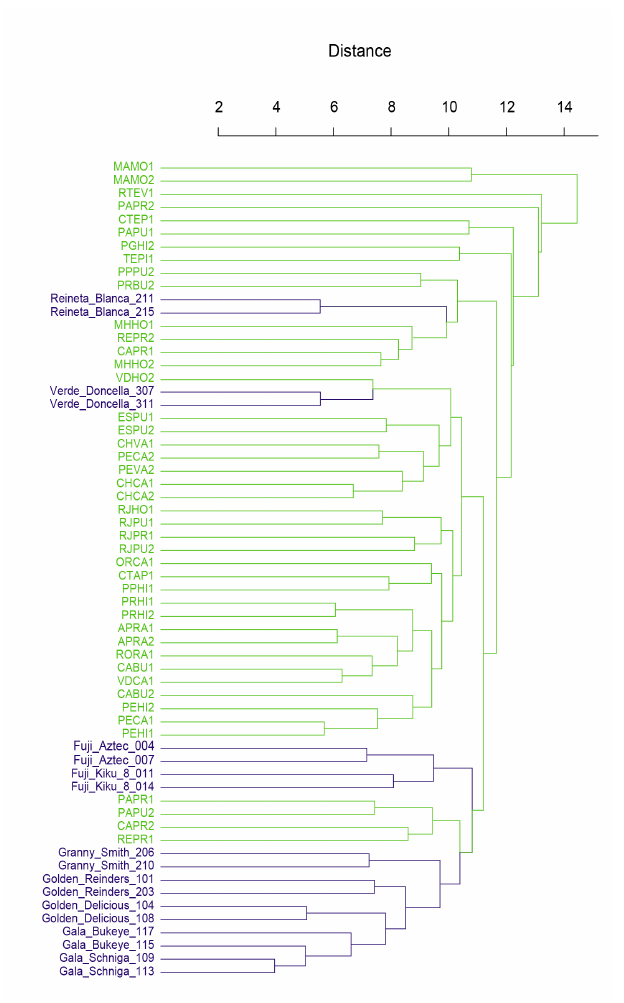
Figure 5. Dendrogram constructed based on unweighted pair group method with arithmetic mean (UPGMA) cluster analysis calculated with the Euclidean distance for all 67 old apple individuals and 18 reference individuals from ‘Fuji’, ‘Gala’, ‘Golden’, Granny Smith’, ‘Reineta Blanca’ and ‘Verde Doncella’ based on 67 morphological descriptors. Purple, references; green, old apple cultivars. Accession and individuals are numbered as in Table 1 and Table 2.